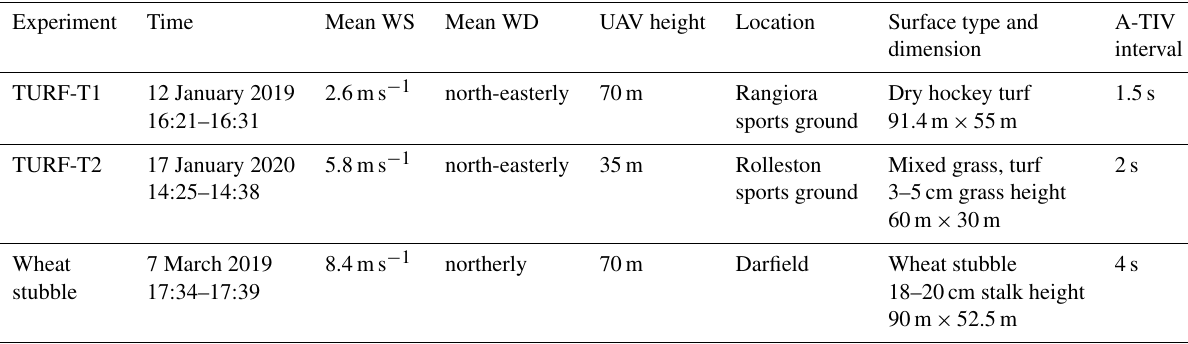
Table 1. Overview of the experiments. Experiment Surface type and A-TIV